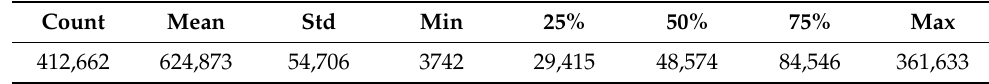
Table 6. Statistics of house price